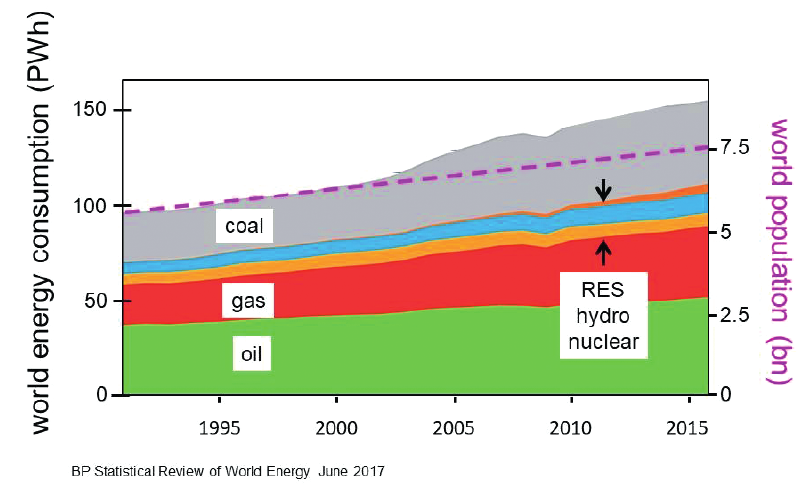
Fig. 2. – Growth of world energy consumption and of world